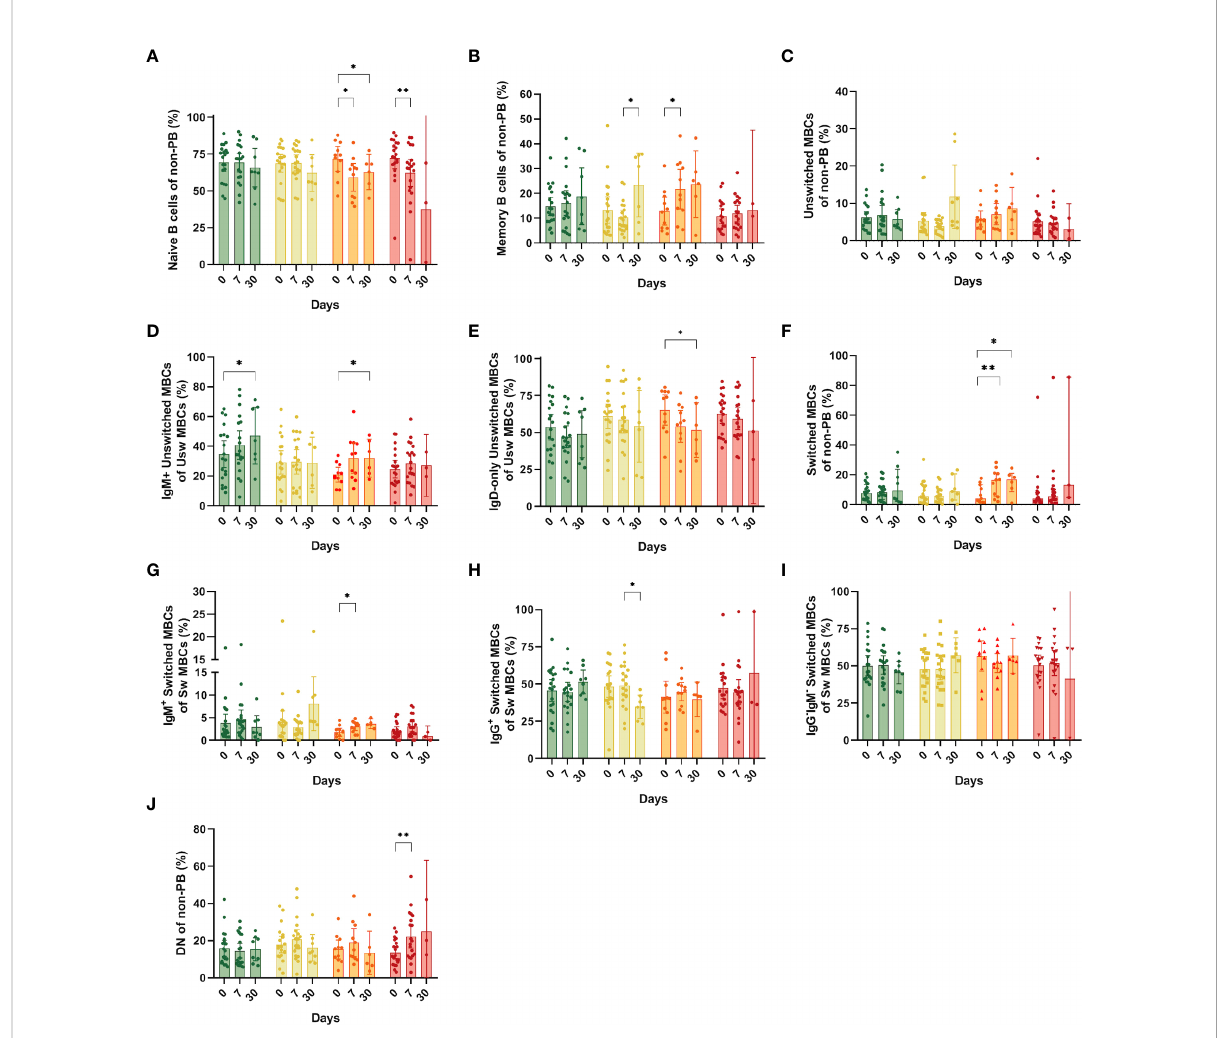
FIGURE 4 Frequencies of memory B cell subsets (MBCs) in the different study groups at days 0, 7 and 30 after recruitment. (A) Naïve B cells; (B) Total MBCs; (C) Unswitched MBCs; (D) IgM + unswitched MBCs; (E) IgD-only (IgM - IgG - ) unswitched MBCs; (F) Switched MBCs; (G) IgM + switched MBCs (pre-switched); (H) IgG + Switched MBCs; (I) IgG - IgM - Switched MBCs; (J) Double negative from the non-PB region. Bars show mean and con fi dence interval (CI, 95%). Data were analyzed using a mixed-effects model with the Geisser-Greenhouse correction with Tukey ’ s multiple comparisons testing between groups. A p-value < 0.05 was considered signi fi cant. *p < 0.05, **p <